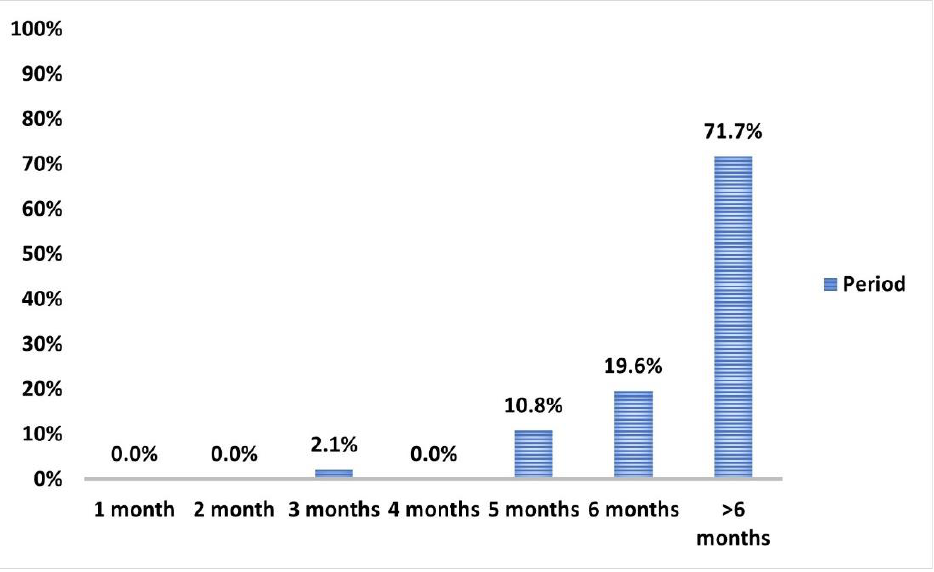
Figure 6. Frequency of time lapse periods from past COVID-19 infection to baseline point of the study among those who experienced infection prior to vaccination ( n = 138). Table 6. Relation between baseline Immunoreactivity and past COVID-19 infection.